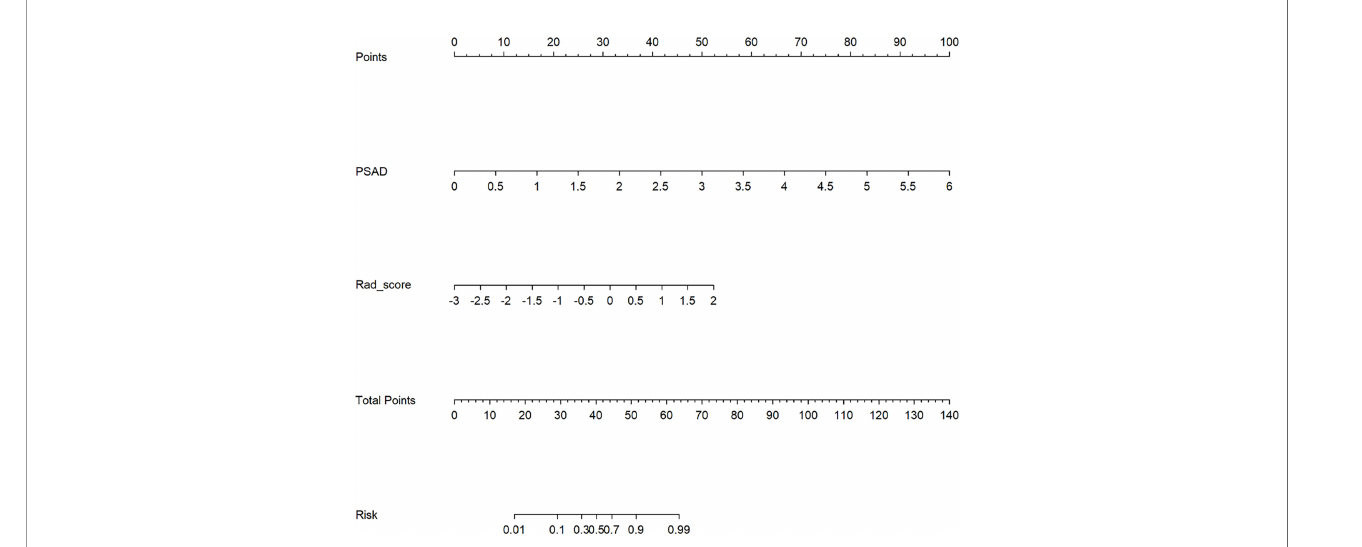
FIGURE 4 | Developed radiomics nomogram for predicting clinically signi fi cant prostate